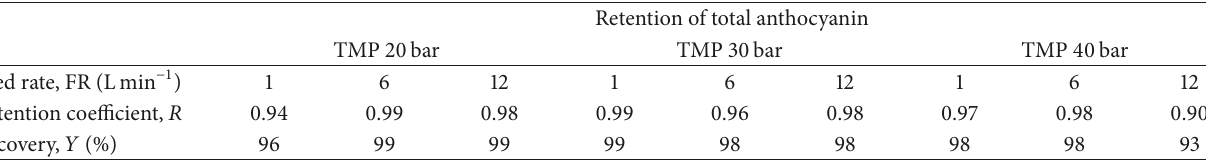
Table 4: Retention coefficient and percentage recovery of anthocyanin on nanofiltration membrane HC-50P DDS at TMP of 20, 30, and 40 bar and feed flow rates of 1, 6, and 12 Lmin −1 .